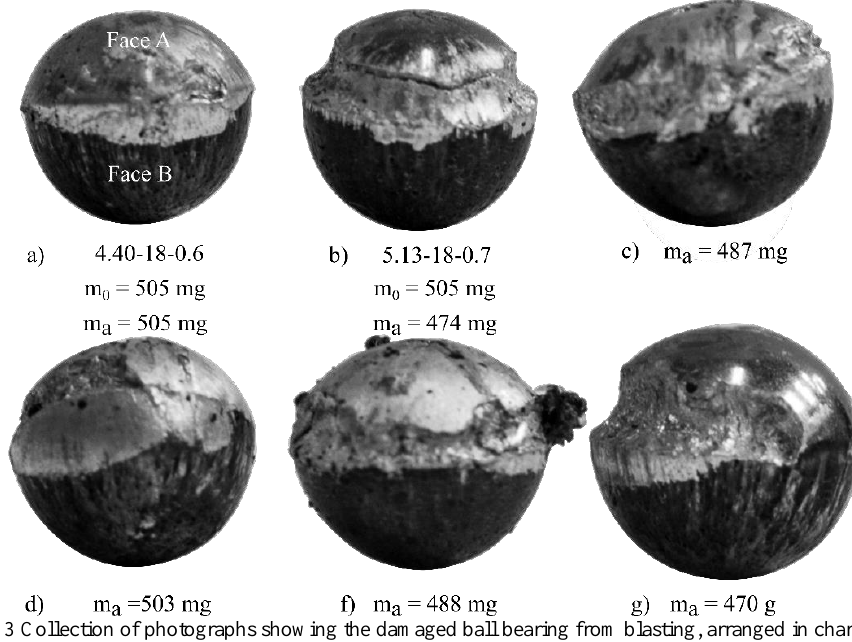
Fig. 3 Collection of photographs showing the damaged ball bearing from blasting, arranged in charge mass of the